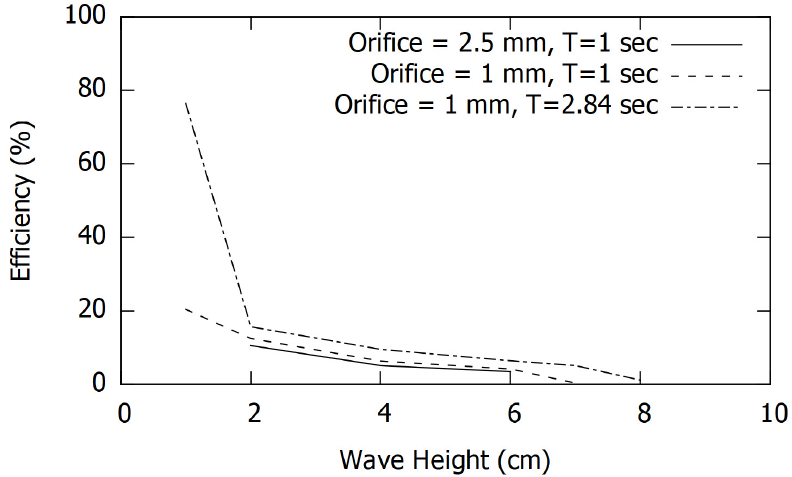
Figure 8. The efficiency of the wave energy devices for different time periods and damping conditions against wave height.